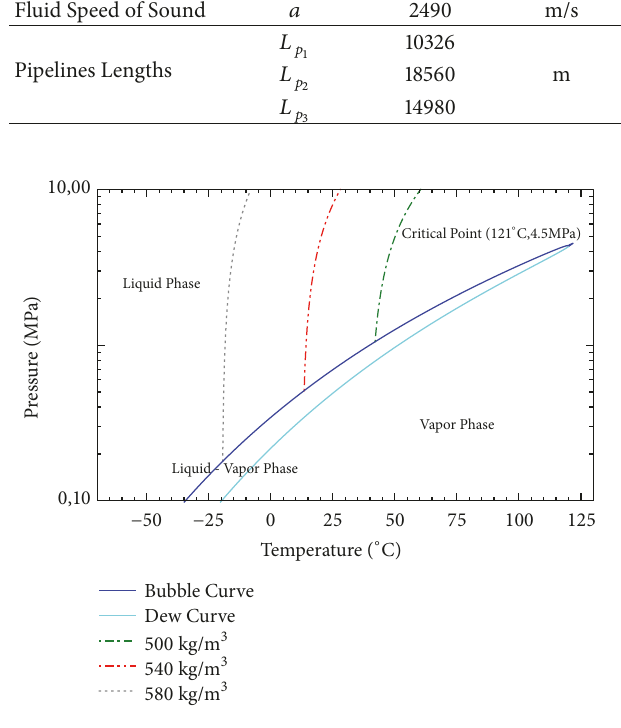
Figure 2: Pressure-Temperature Diagram of (40% butane–60% propane)